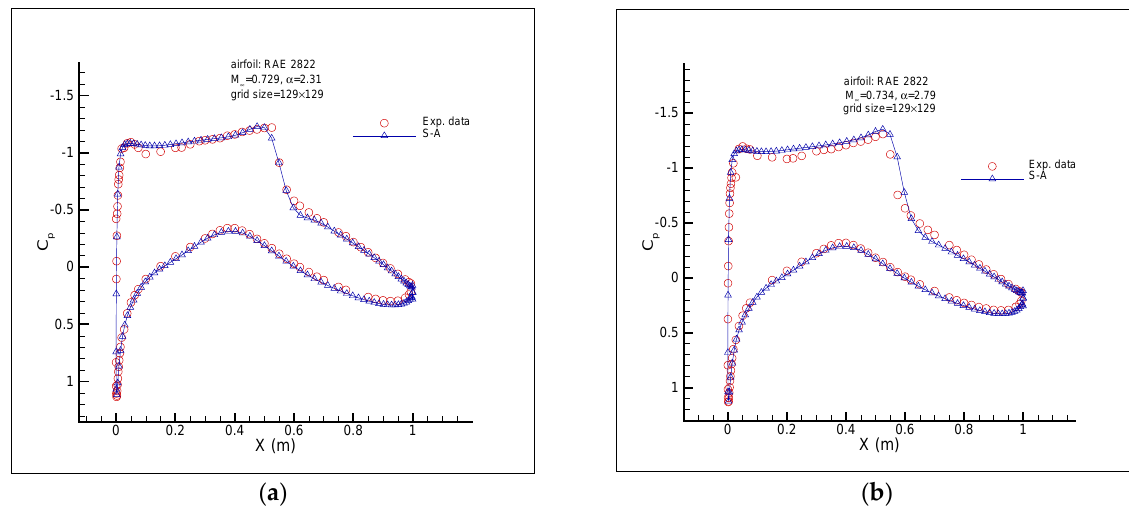
Figure 7. Structured mesh (hyperbolic O-type) around the RAE2822 airfoil used for solving the transonic turbulent flow Equations. The grid size and the wall spacing are m , respectively.